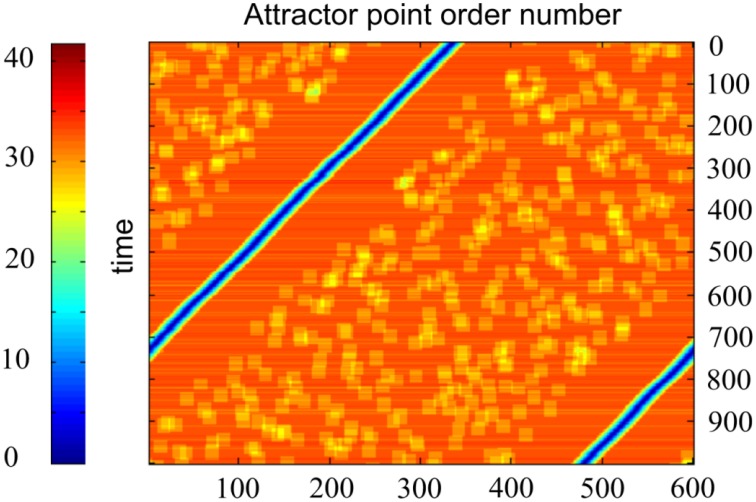
Time plot of distances between the current activity state and candidate activity states, enumerated by the marker order number. One horizontal line corresponds to one time moment. Abscissa—network state order number; ordinate—time. Color code for each point of each line shows how close is activity of the network to the state, which order number is at the abscissa. N = 300, M = 600, D = 80, δ = 12, σ = 3, other parameters are the same, as in Figure 4. The Figure demonstrates that the activity of the network in fact attends the candidate states, enumerated at the abscissa.